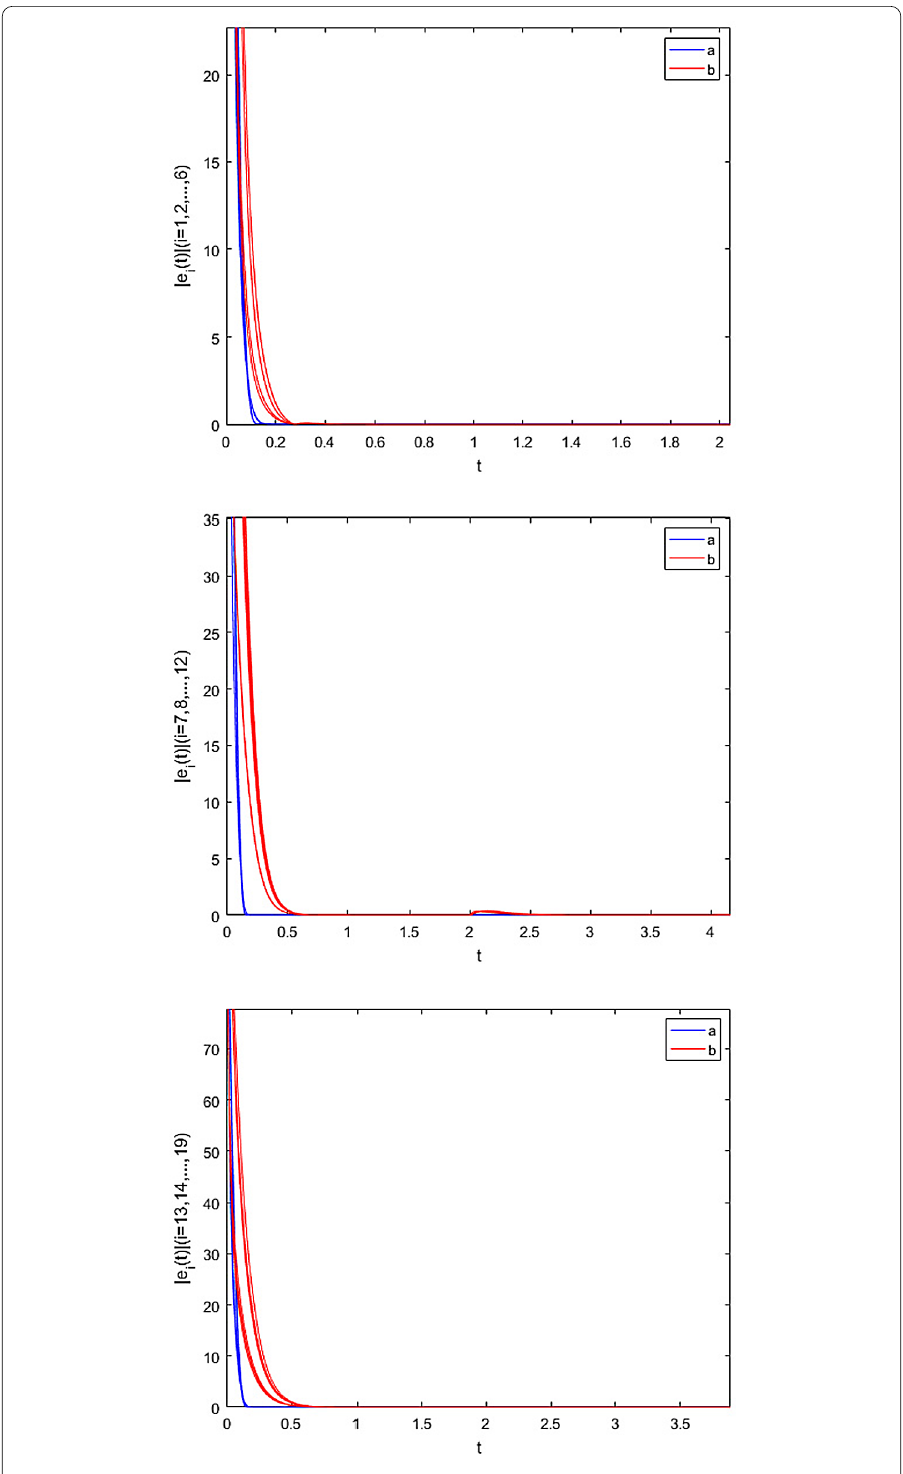
Figure 7 The finite-time synchronization errors and the asymptotic synchronization